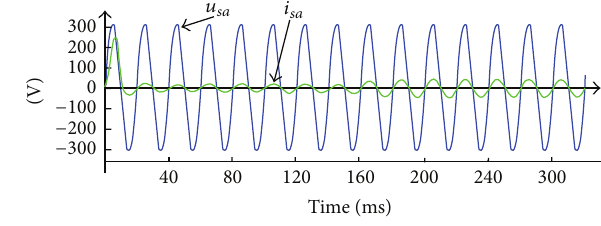
Figure 6: Waves of power grid voltage and current (load changes).